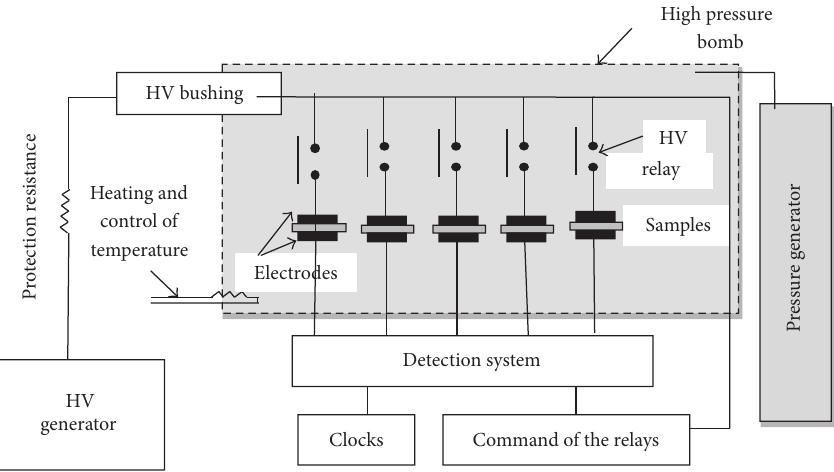
Figure 1: Electrical ageing measurement setup under hydrostatic pressure.